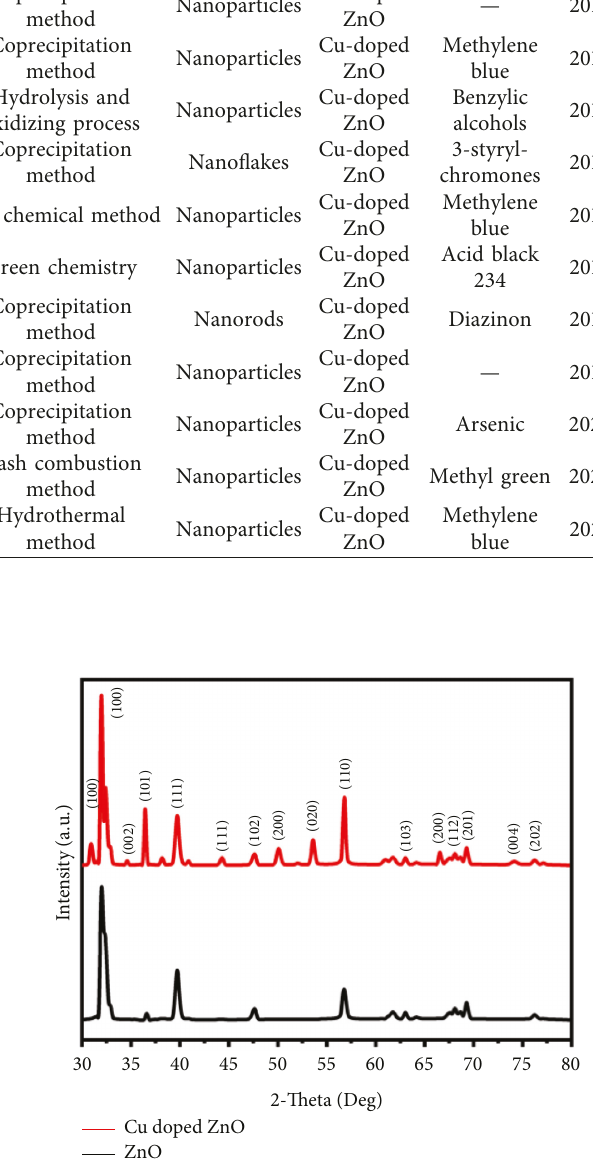
Figure 1: XRD pattern of pure and Cu-doped ZnO NPs dem- onstrating peaks for various components in the